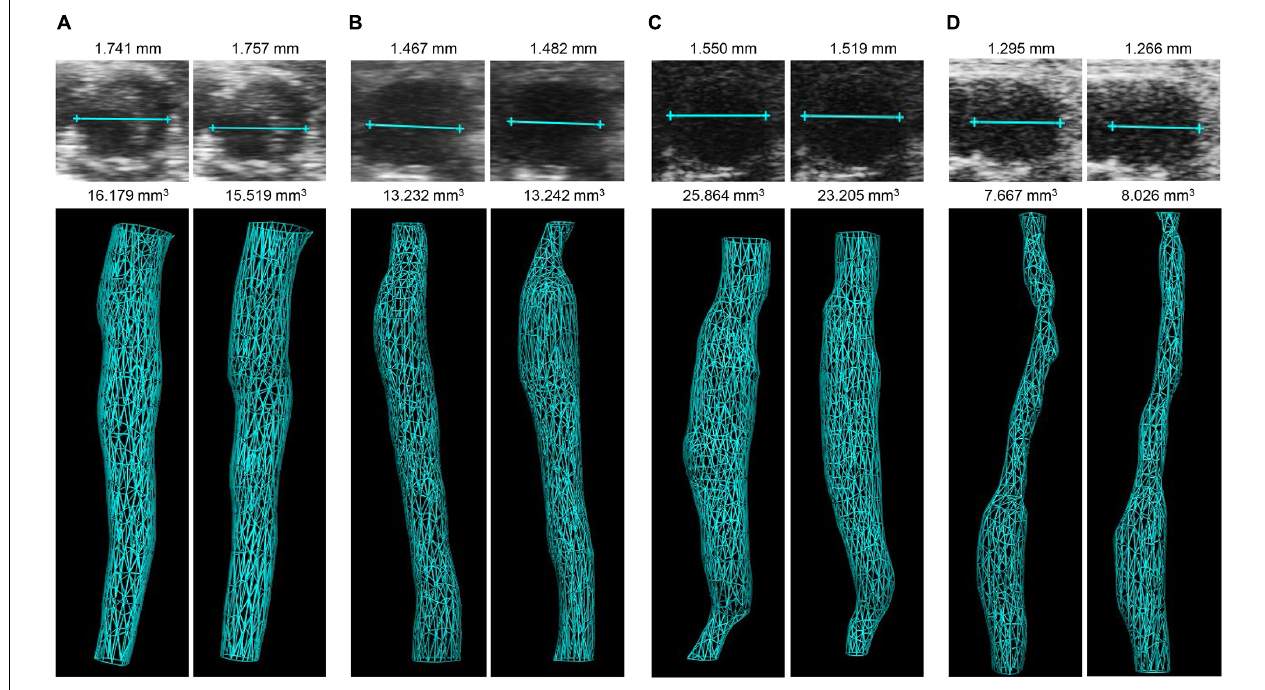
Frontiers in Cardiovascular Medicine |